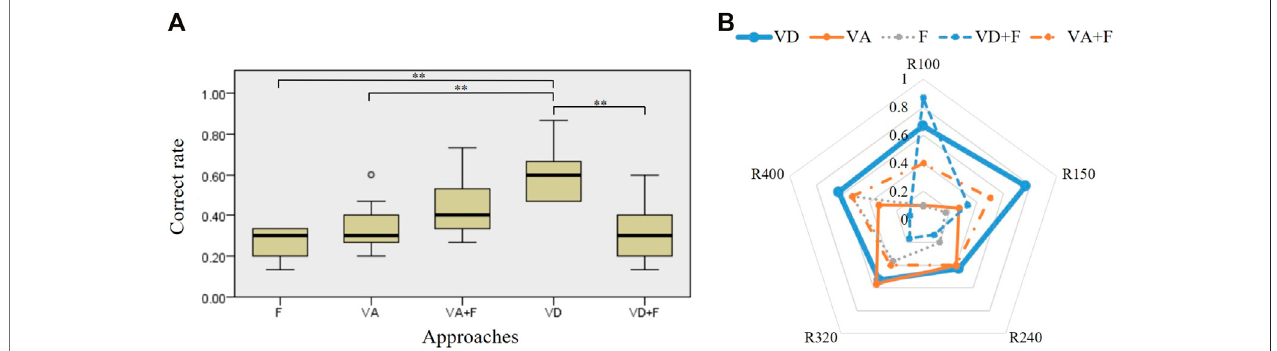
FIGURE14| Correct ratesof fi veapproaches. (A) Average ofcorrect ratesforallsandpapers amongeach participant, **: p < 0.05;and (B) correctratesofeach of the fi ve approaches when reproducing each sandpaper.